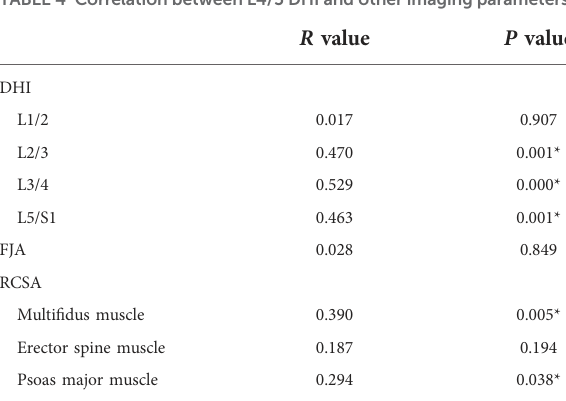
TABLE 4 Correlation between L4/5 DHI and other imaging